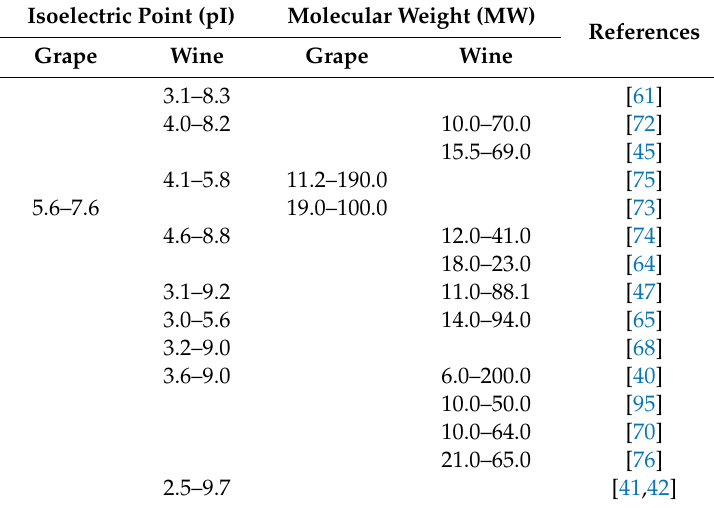
Table 1. Isoelectric point (pI) and molecular weight (kDa) identified in di ff erent protein fraction from grape and